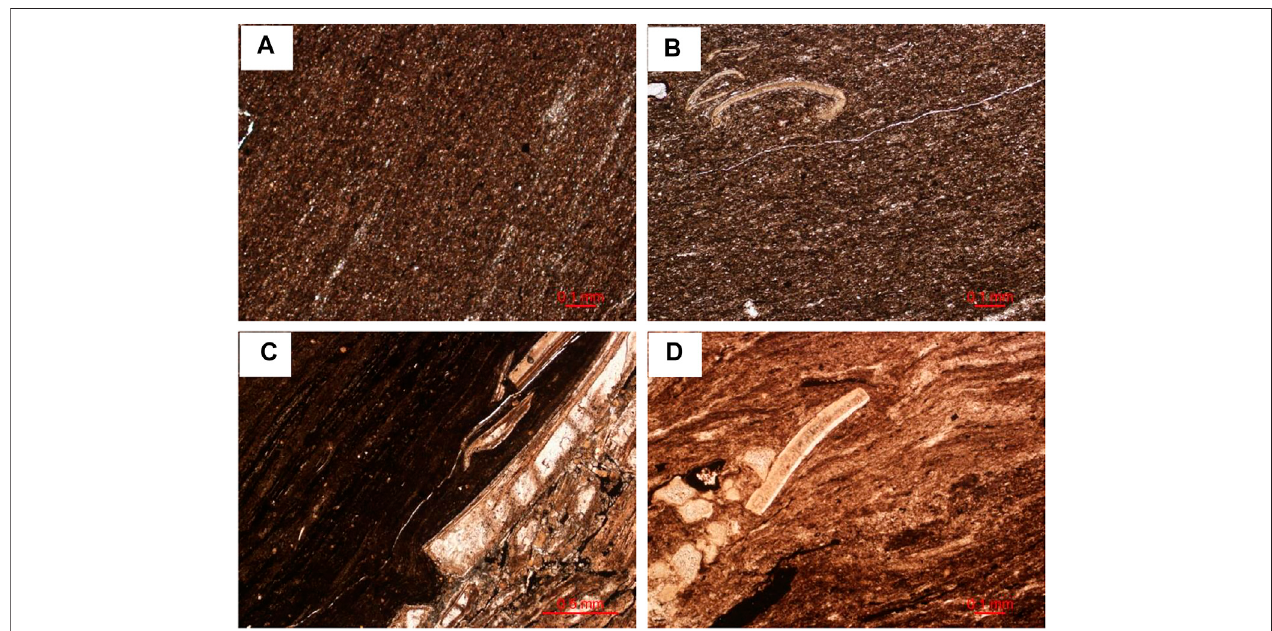
FIGURE 3 | Microscopic Features of Main Lithofacies in Dongyuemiao shale of Well FY10 (A) argillaceous shale, 2,801.11 m; (B) argillaceous shale, 2,802.97 m; (C) mixed shale, 2,790.79 m; (D) mixed shale, 2,792.46 m.